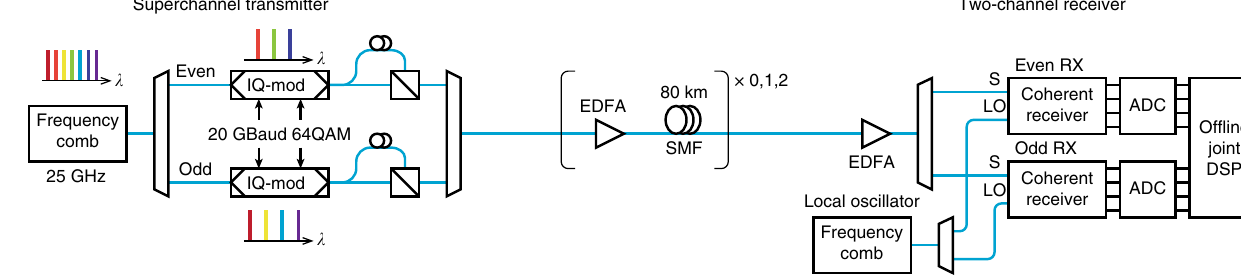
Fig. 2 Experimental setup for phase-coherent communication. The lines of an electro-optic frequency comb are divided into even and odd, modulated separately with data and then combined. The signal is transmitted through up to two 80-km fi ber spans. In the receiver, one even and one odd channel can be picked to be received simultaneously. A second frequency comb supplies the local oscillator. Digital signal processing (DSP) is performed of fl ine. IQ in- phase quadrature, EDFA erbium-doped fi ber ampli fi er, SMF standard single-mode fi ber, S signal, LO local oscillator, RX receiver, ADC analog-to-digital